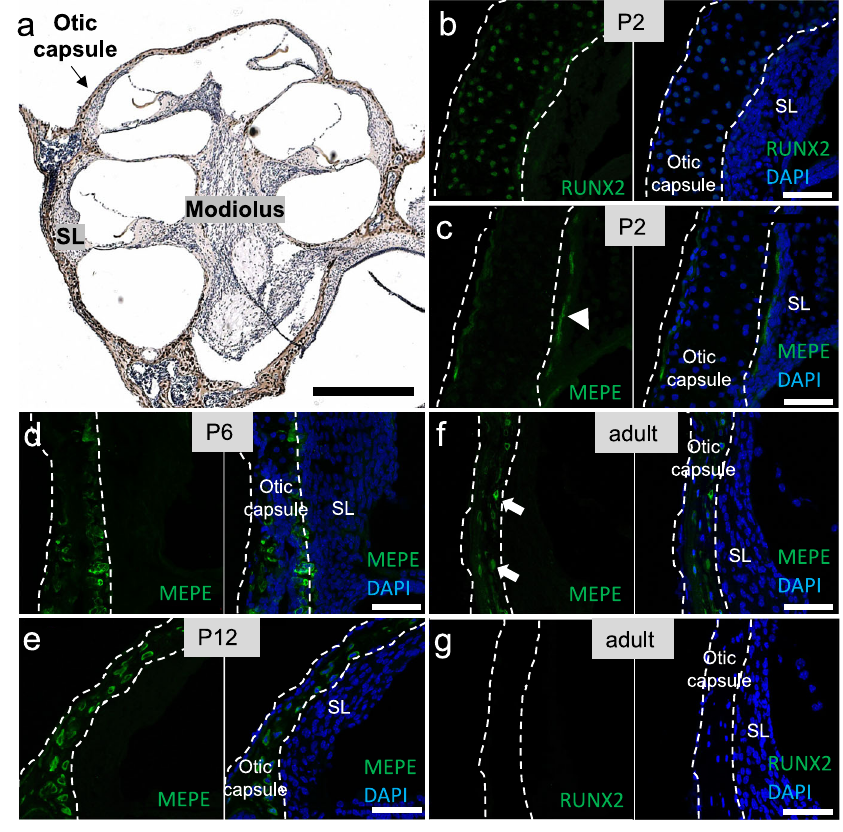
g LackofRUNX2expressionintheadultoticcapsule. c – f Immuno fl uorescencefor MEPE (green) developed from more diffuse ( c white arrowhead) to more clearly cellularly localized ( f white arrows) with age. SL Spiral ligament. Representative images of N =3 animals per age group. Scale bars: a: 500 µ m, b – g 50 µ